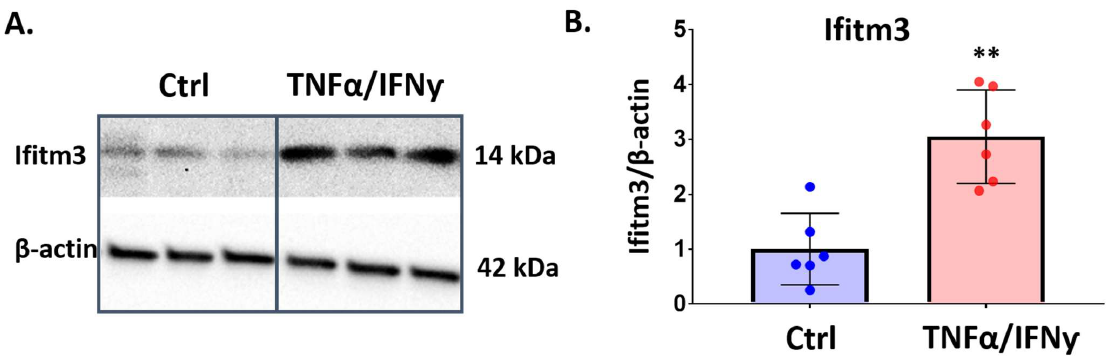
Figure 7. The IFITM3 protein level is increased by TNFα and IFNγ in primary microglia. Primary microglia were treated with TNFα and IFNγ (20 ng/mL) for 24 h. Western blotting was performed to measure protein level of IFITM3. ( A ) IFITM3 (seen at 14 kDa) was increased in the treatment group, compared to control. ( B ) Quantification of IFITM3 to β-actin showed the significant induction of IFITM3 protein in microglia ( n = 6, ** p < 0.01, two-tailed unpaired Student’s t -test). We also utilized Sim-A9 cells, an immortalized murine microglial cell line. This murine microglial-like cell line is known to respond quickly to inflammatory stress and exhibit phagocytic characteristics which are common features of CNS resident microglia. We tested whether TNFα and IFNγ treatment on Sim-A9 cells could induce Ifitm3 mRNA expression. Interestingly, Ifitm3 expression was induced to a greater degree by treatment with 20 and 40 ng/mL of TNFα and IFNγ in Sim-A9 cells compared with primary microglia (Figure 8, n = 4–8, * p < 0.05 compared to control). Figure 8. Ifitm3 expression is increased in TNFα and IFNγ treated microglial cell line, Sim-A9 cells. Sim-A9 cells were treated with TNFα and IFNγ (20 ng/mL and 40 ng/mL) for 24 h. qRT-PCR was